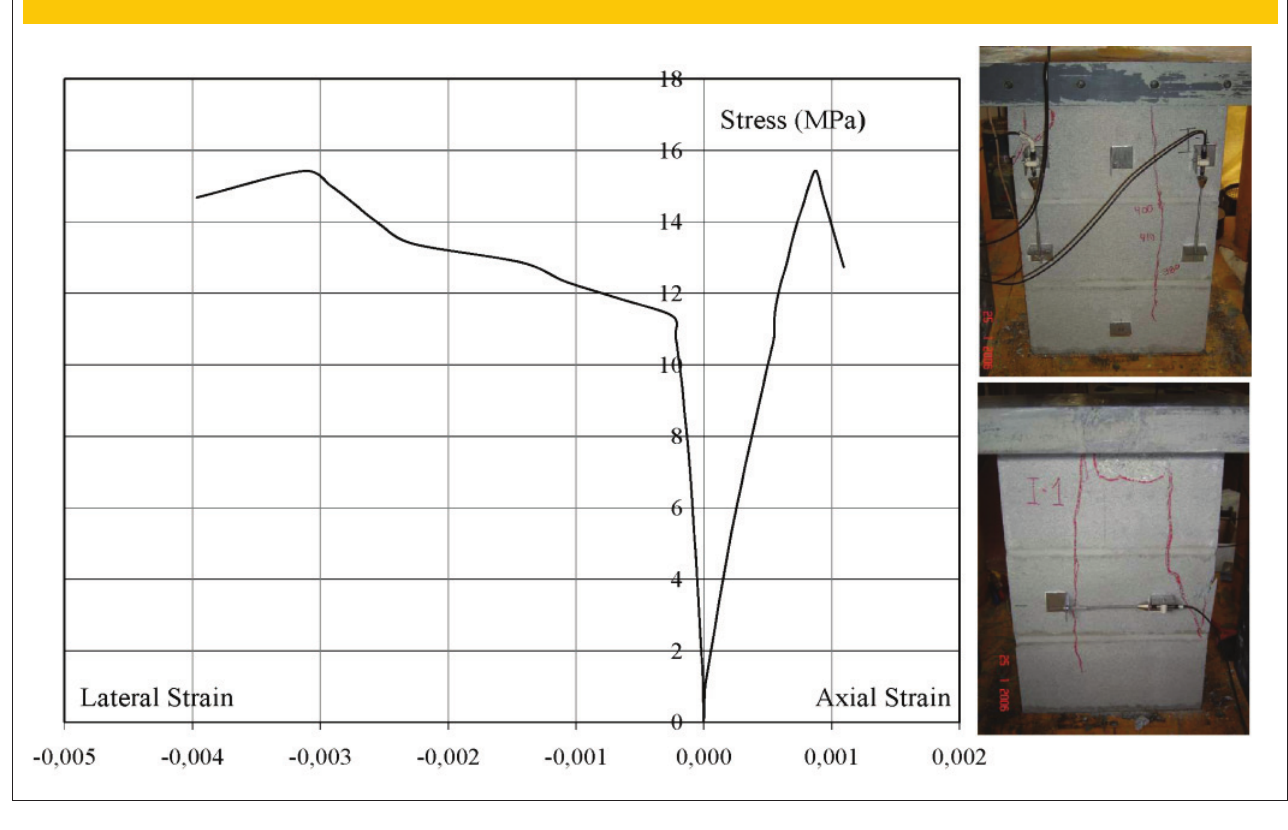
Figure 9 – Typical stress-strain diagram for prism A and mortar mix I